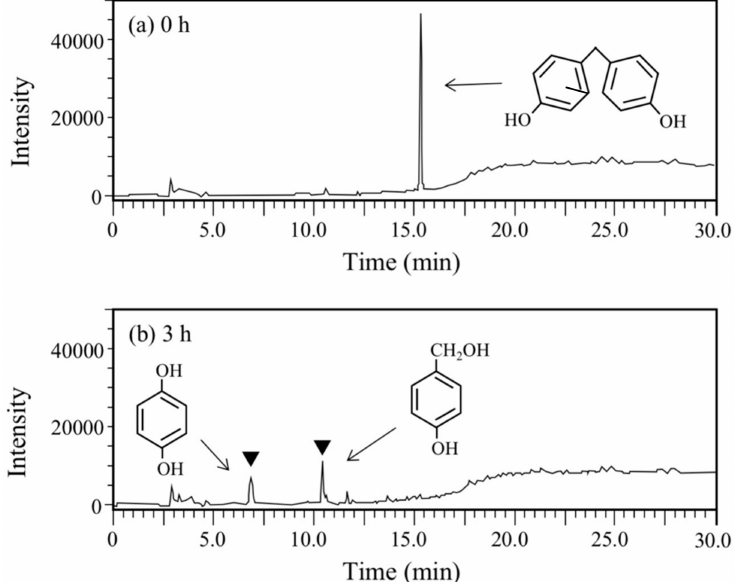
Figure 5. Chromatograms from HPLC analysis of the cell suspension samples of P. putida KT2440 harboring pBNMOA-F ( nmoA ) in the BPF degradation test. ( a ) Starting point (0 h), and ( b ) after 3-h incubation (3 h). Arrowheads show newly appeared peaks in the degradation, which were later identified as HQ and 4-hyroxybenzylalcohol by GC / MS and HPLC